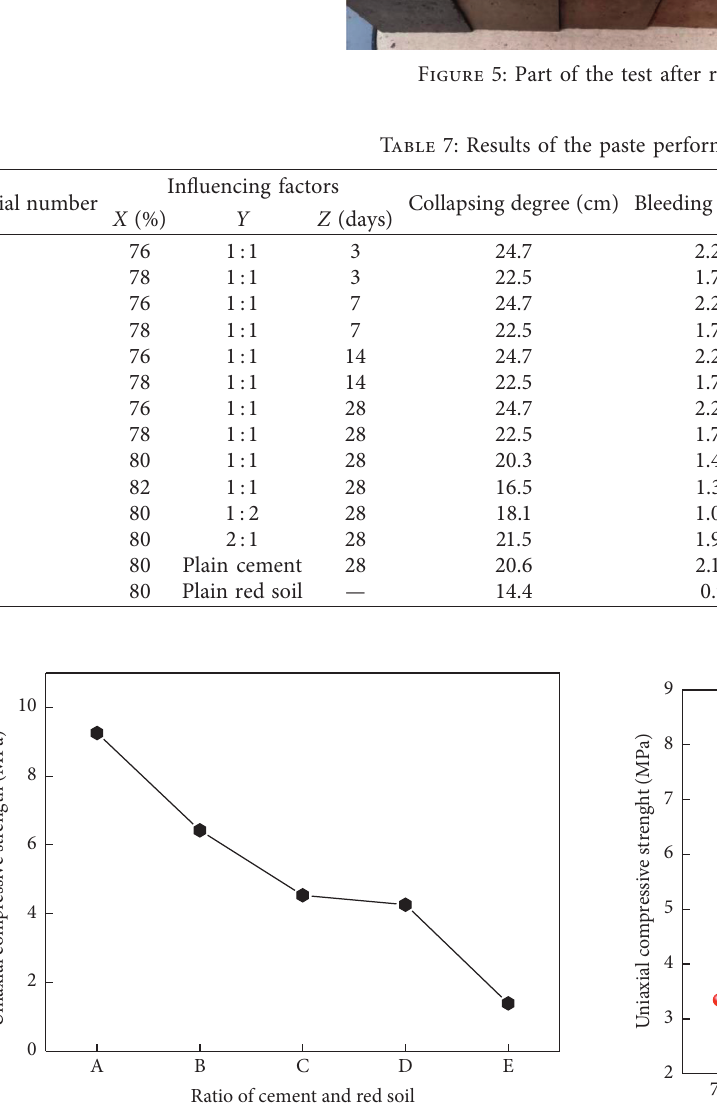
Figure 6: The law of influence between cement and red soil ratio on the strength of filling. Figure 7: The law of influence of slurry concentration on the strength of